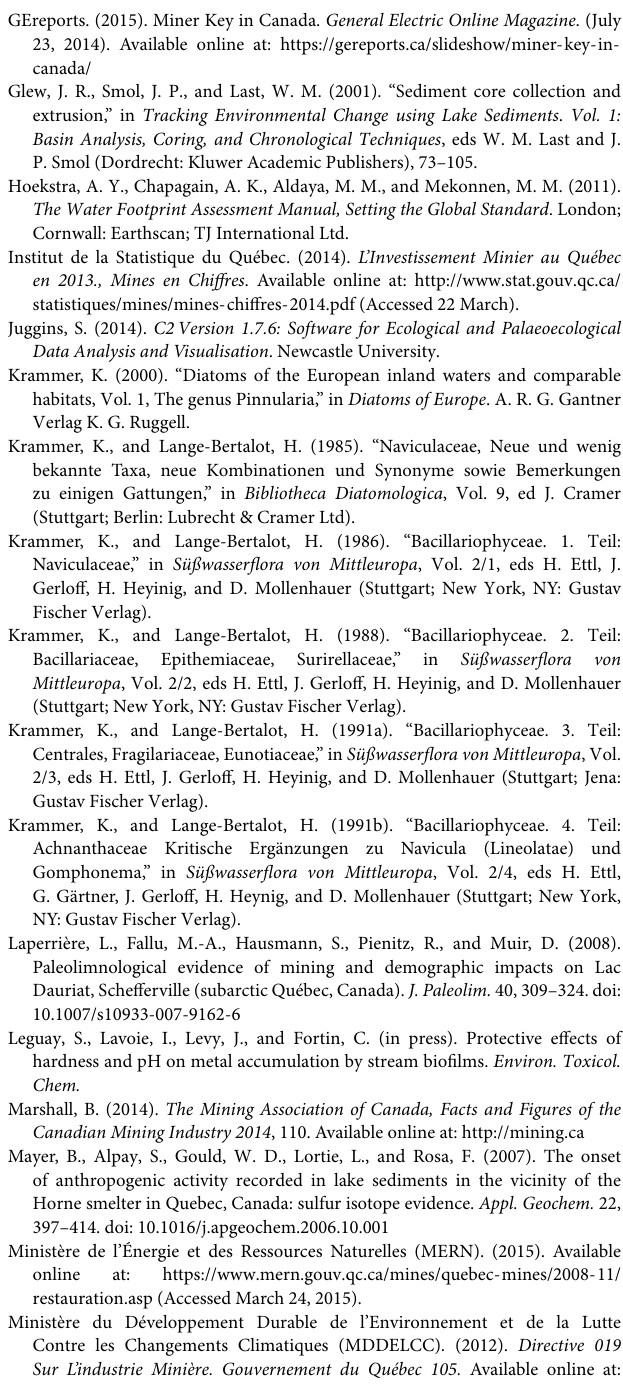
Figure S1 | SEM images of the prominent diatoms in Lake Arnoux. 1, Frustulia saxonica , whole valve external view; 2, Frustulia saxonica , valve apex internal view; 3, Pinnularia subcapitata var. elongata , internal view; 4, Pinnularia subcapitata var. elongata , apex internal view; 5, Tabellaria flocculosa , external view; 6, Asterionella formosa , external view; 7, Aulacoseira subarctica , external view; 8, Aulacoseira pusilla , external view. Scale bars: 1 = 20 µ m; 3, 5, 6 = 10 µ m; 2 = 5 µ m; 4, 7, 8 = 2 µ m.